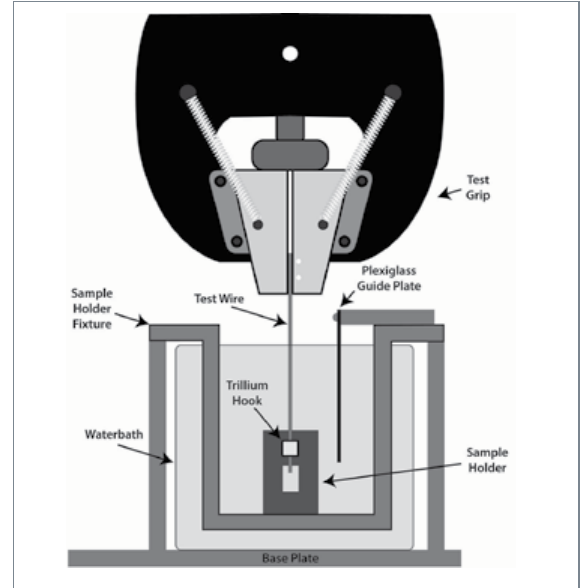
Figure 2. A schematic illustration of the experimental